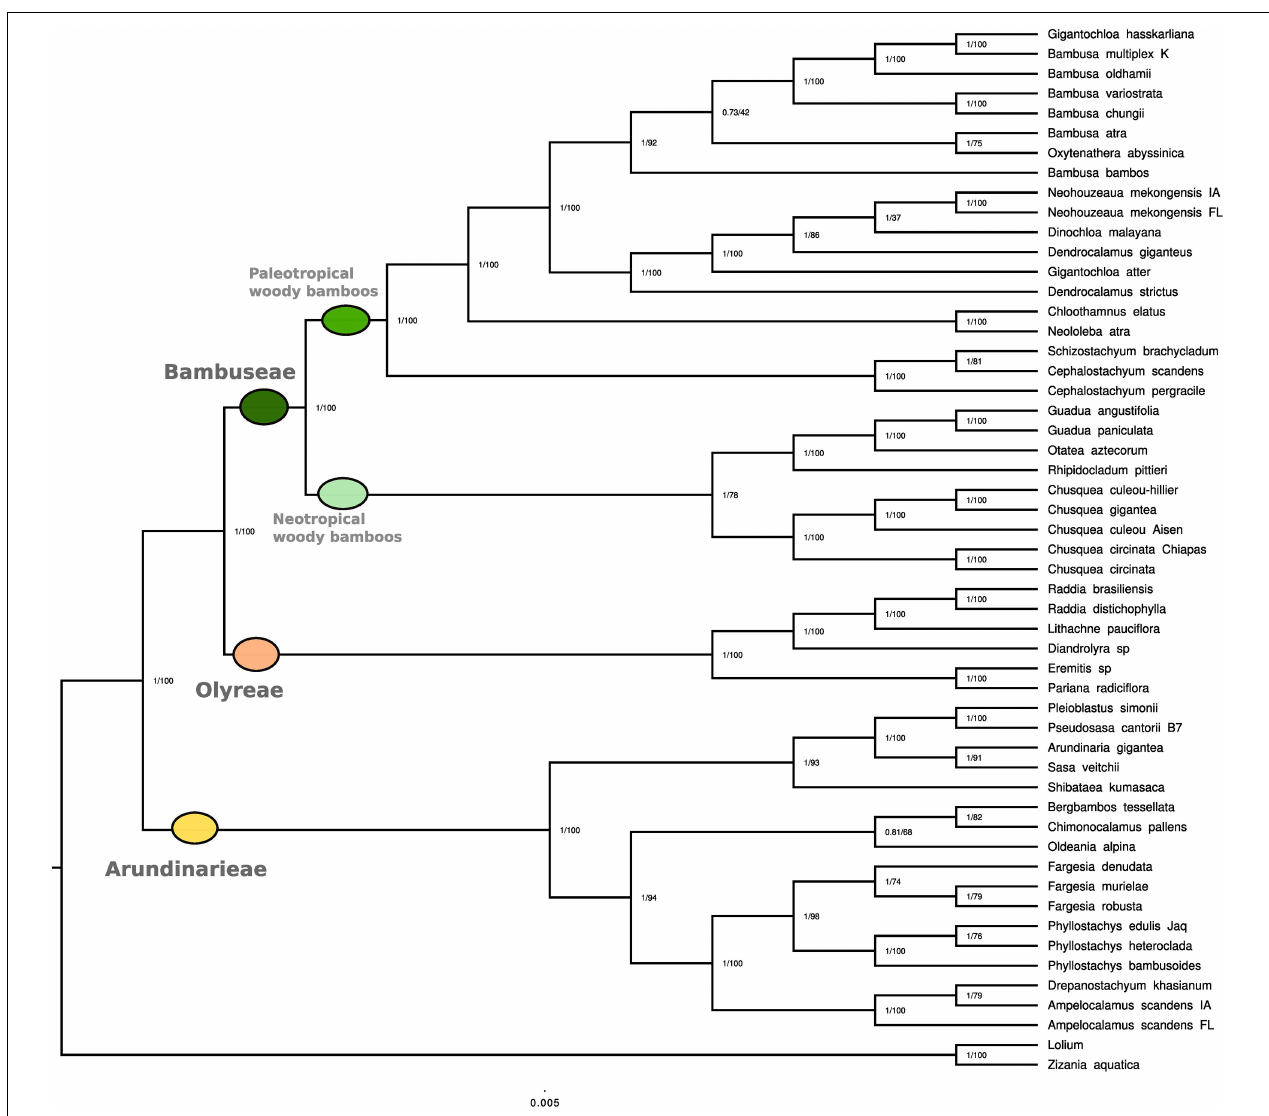
FIGURE 2 | Phylogenetic reconstruction based on full plastome sequences. Phylogenetic reconstruction using whole plastid genomes representing 51 bamboo species. Two non-bamboo plastomes were added as outgroups ( Lolium multiflorum and Zizania aquatica ). Among the 51 collected species, plastome data were already available for 17 of them. Values represent Bayesian posterior probability and maximum likelihood bootstrap scores, respectively.